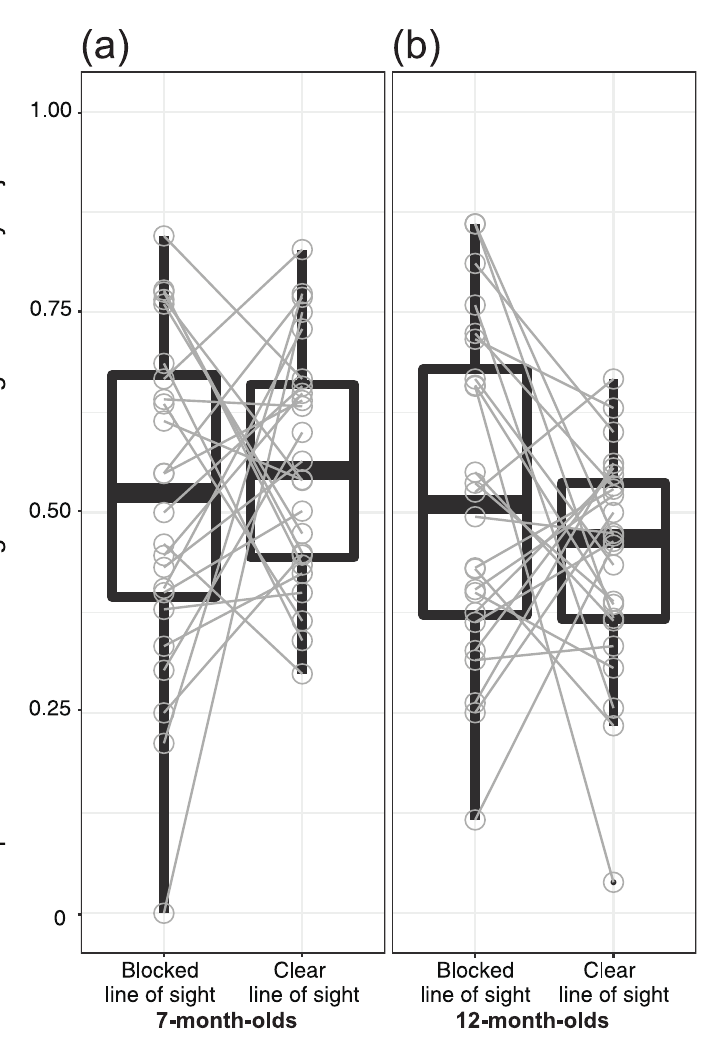
Fig 4. Proportion of the total looking time on the gaze-cued toy object for the Blocked Line of Sight and Clear Line of Sight Conditions. Results are shown for the (a) 7-month-old infants and (b) 12-month-old infants. The central mark indicates the median. The bottom and top edges of the box indicate the 25th and 75th percentiles, respectively. The upper whisker (vertical line) extends from the third quartile to the largest value. However, this was no further than 1.5 interquartile ranges from the third quartile. The lower whisker extends from the 25th percentile down to the smallest value. However, this was no further than 1.5 interquartile ranges from the first quartile.